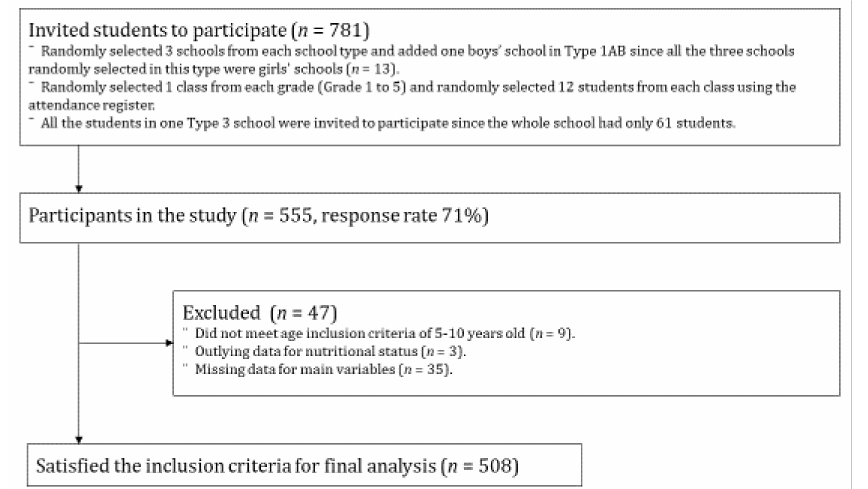
Figure 1. Participant flow chart in the sample for